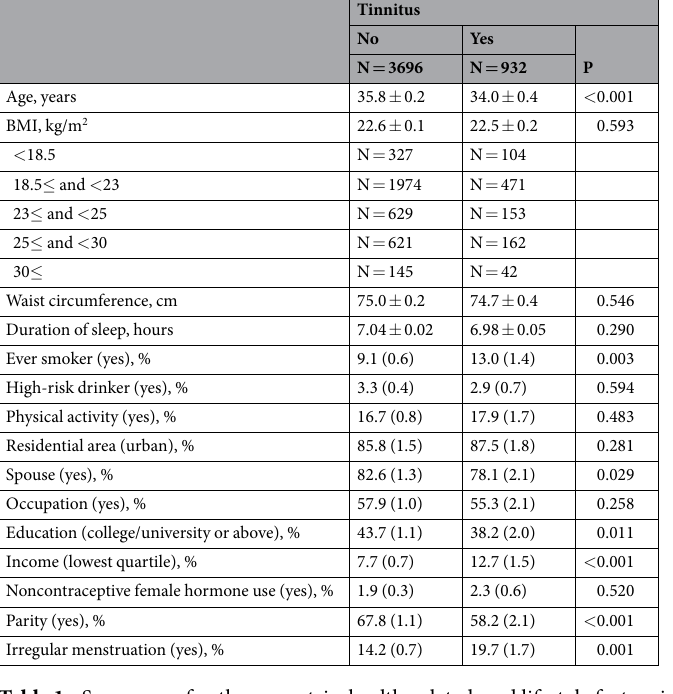
Table 1. Summary of anthropometric, health-related, and lifestyle factors in the study population. Data are presented as mean ± standard error (SE) or